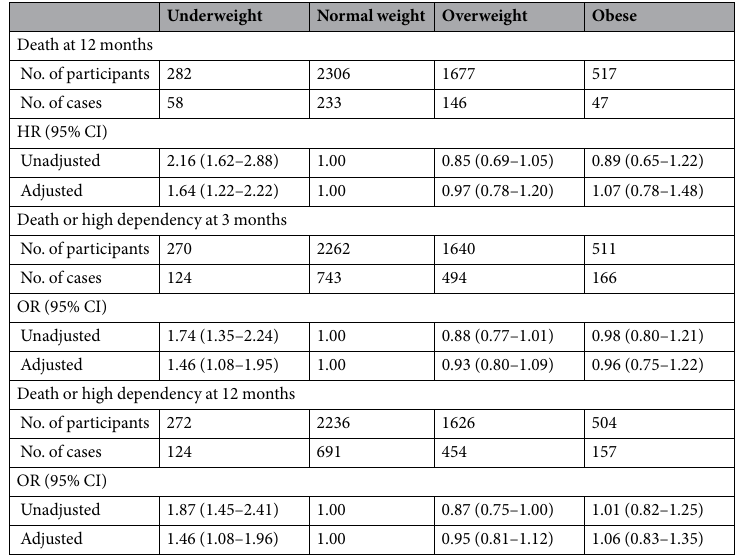
Table 2. Body mass index related to risk for death at 12 months, death or high dependency at 3 and 12 months. CI, confidence interval; HR, hazard ratio; OR, odds ratio. The adjusted analyses included the following covariates: age, sex, living partnership, education level, annual household income, medical history of hypertension, diabetes, hyperlipidaemia, atrial fibrillation, prior stroke or TIA, coronary artery disease, and prior dependency, current smoking status, regular alcohol consumption, time of presentation to hospital, Glasgow Coma Scale score on admission and Oxfordshire Community Stroke Project classification on